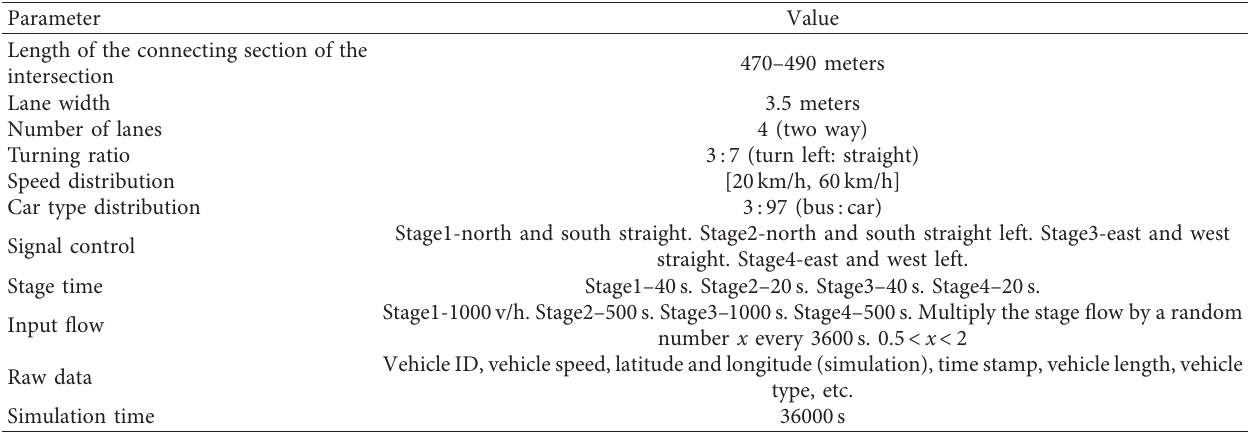
Table 2: VISSIM simulation settings.